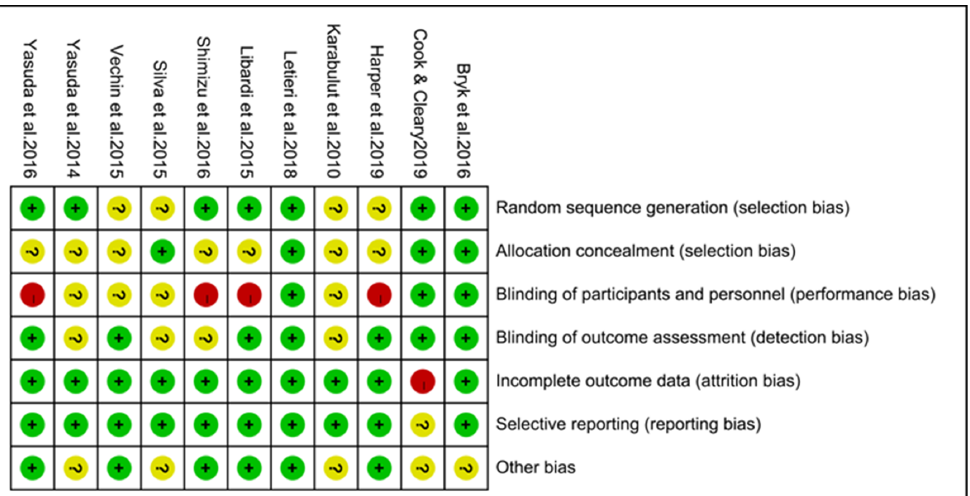
Figure 3. Risk of bias summary plot of included studies [19,22,29–37]. Green represents (+) low risk, yellow represents (?) unclear, and red ( − ) indicates high risk of bias.